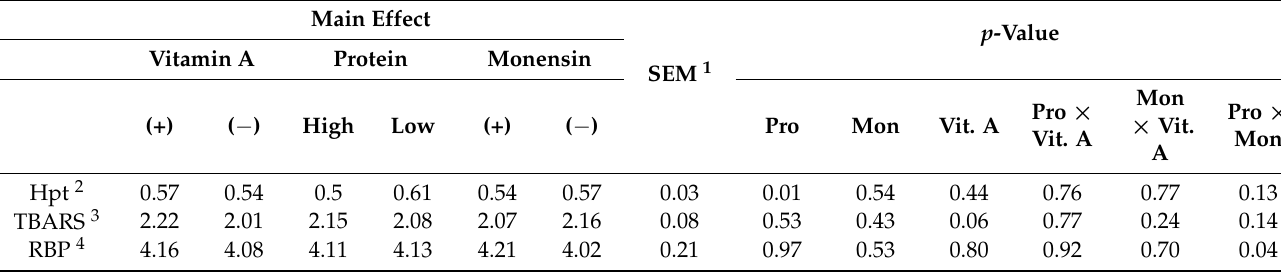
Table 5. Serum metabolites for multiparous Holstein dairy cows ( n = 80, total) that were fed diets with crude protein levels (10.3%, n = 40 vs. 12.2% dry matter basis, n = 40), and within each crude protein group fed monensin (400 mg/day per head or none) and vitamin A (110 IU/kg body weight or none) during prepartum period (from day − 35 to the day of calving). All cows received a common lactation ration